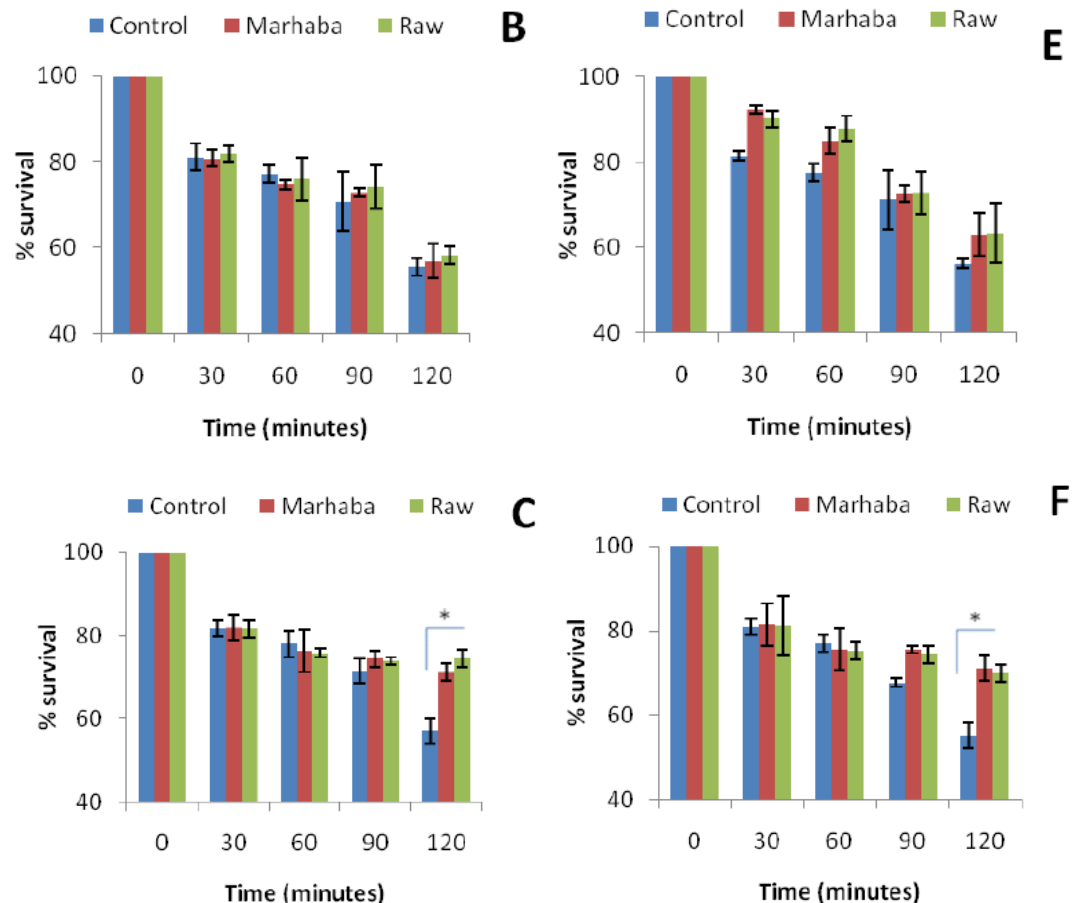
Figure 3. E ff ect of temperature (60 ◦ C) in E. coli ATCC 10536 ( A , D ); S. Typhi ( B , E ) and K. pneumoniae Figure 3. Effect of temperature (60 ° C) in E. coli ATCC 10536 ( A , D ); S. Typhi ( B , E ) and K. pneumoniae ( C , F ) survival after the fourth passage of adaptation at 1 ( C , F ) survival after the fourth passage of adaptation at ¼ × MIC ( A – C ) and the eighth until ½ × MIC ( D – F ) of branded and unbranded honey. ( p > 0.05); * ( p < ( D – F ) of branded and unbranded honey. ( p > 0.05); * ( p < 0.05).